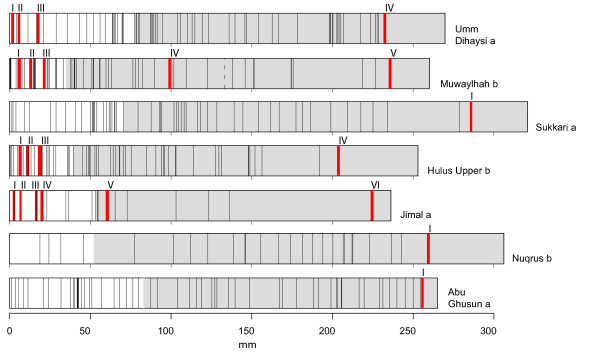
Sketch of dated cores. Red areas indicate sample location. Black lines are parenchymatic bands (appear as black areas when several rings are close together). The white part of the core is sapwood, the grey is heartwood. Dashed lines indicate a gap in the core.